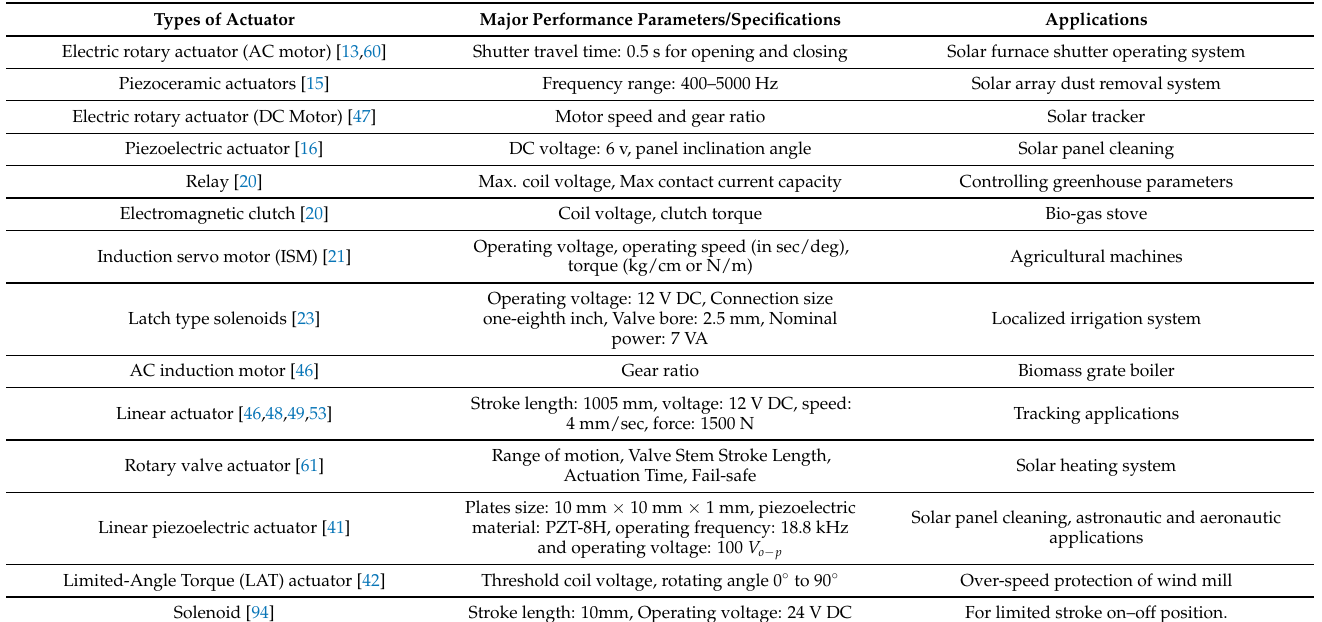
Table 6. Summary of Major Performance Parameters, Specifications, and